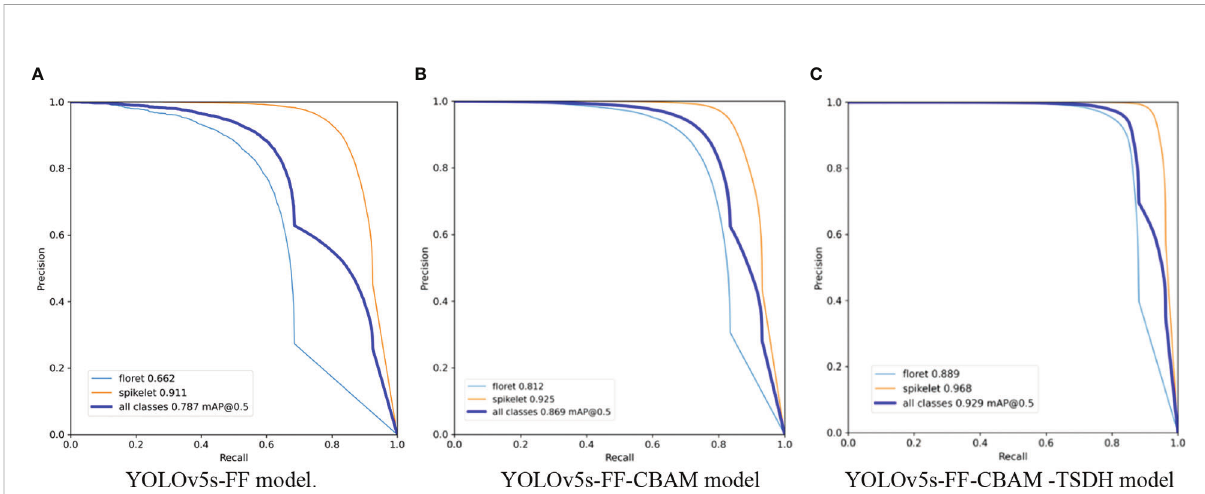
FIGURE 14 The precision-recall curves of fl orets and spikelets by different models. (A) precision-recall curve of YOLOv5s-FF model( fl oret 0.662 mAP@0.5, spikelet 0.911 mAP@0.5). (B) precision-recall curve of YOLOv5s-FF-CBAM model( fl oret 0.812 mAP@0.5, spikelet 0.925 mAP@0.5). (A) precision- recall curve of YOLOv5s-FF-CBAM-TSDH model ( fl oret 0.889 mAP@0.5, spikelet 0.968